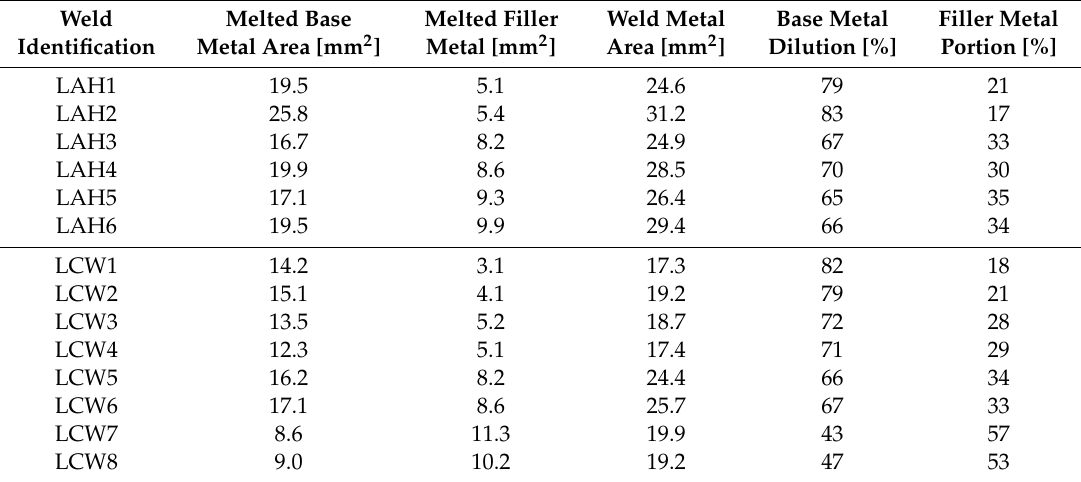
Table 4. Summary of cross-sectional areas of laser arc-hybrid (LAH) and laser cold-wire (LCW) test welds. Welding energy input values per weld length [kJ / mm]: LAH1&2 = 0.57; LAH3&4 =